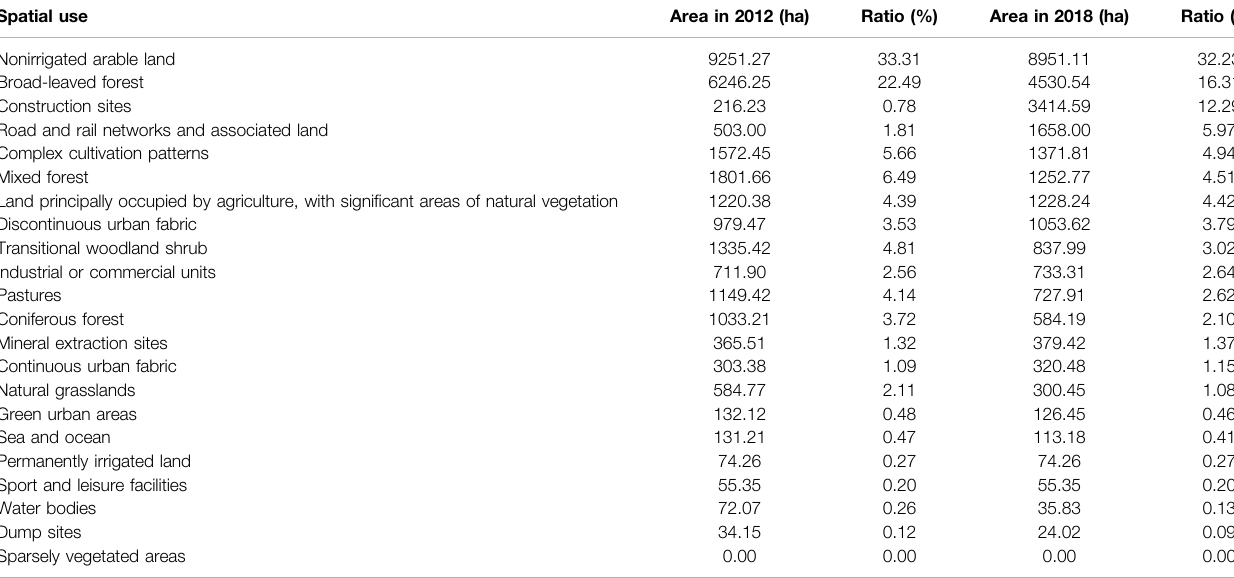
TABLE 2 | Distribution of spatial use types within the impact zone in 2012 and 2018. Spatial